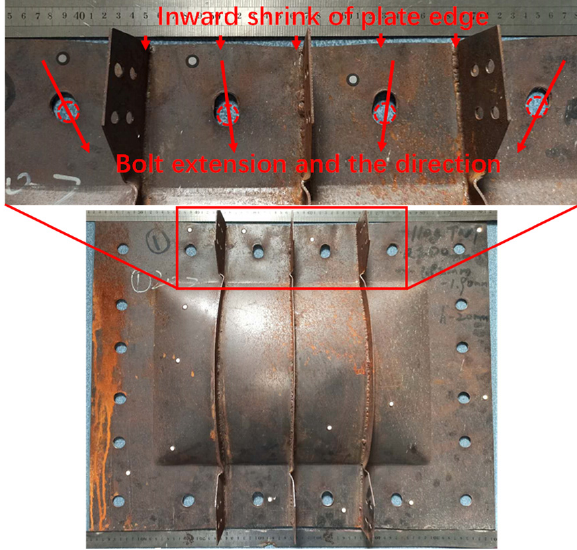
Figure 15. Edge shrink and bolt extension.